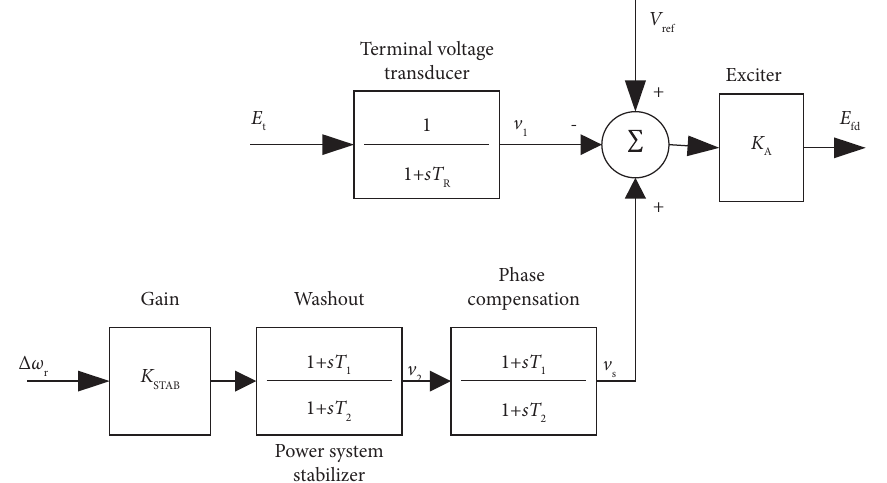
Figure 6: Tyristor excitation system including AVR and